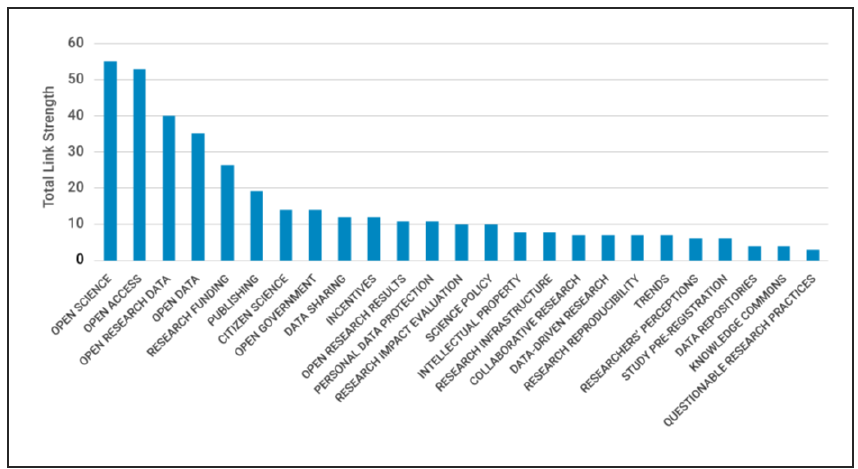
Fig. 3. The most important keywords (concepts) related to